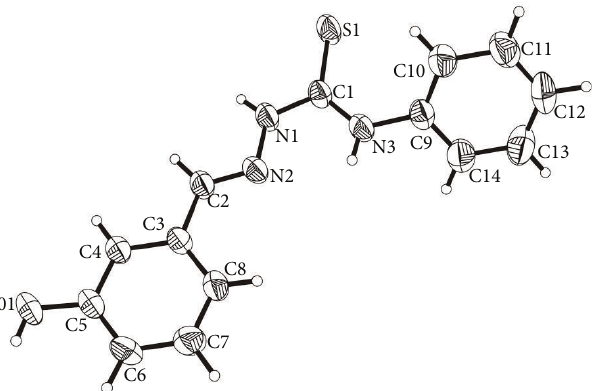
Figure 1: Molecular structure of HTSC 3 ( 3 ). The displacement ellipsoids are drawn at the 50% probability.